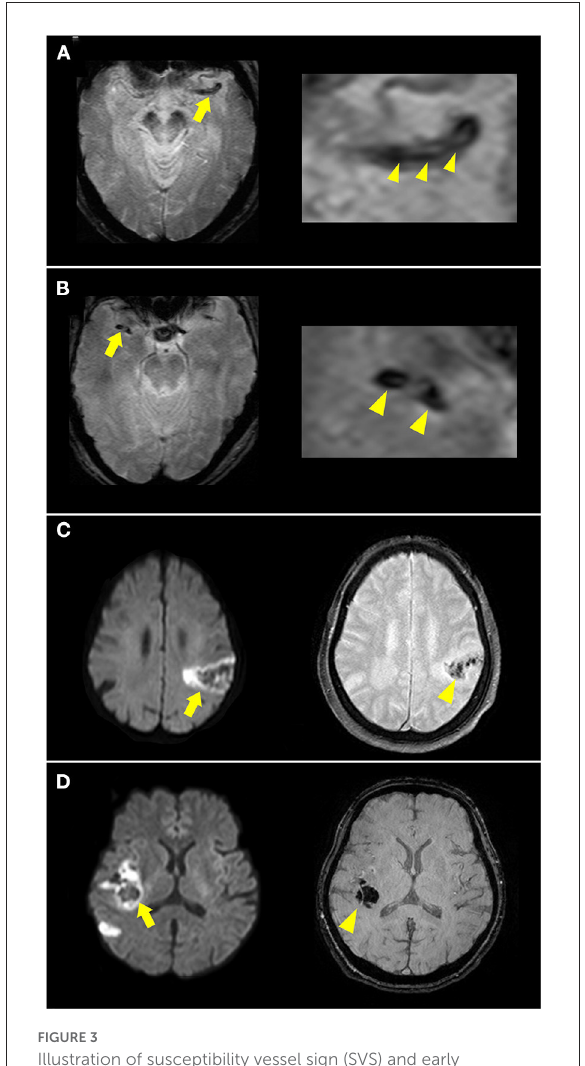
FIGURE3 Illustration of susceptibility vessel sign (SVS) and early hemorrhage. (A) A hypointense signal was noted at the left occluded middle cerebral artery (MCA) [ (A) , arrow] in T2*-weighted imaging, with a low-intensity core surrounded by a signal of higher intensity [ (A) arrowheads], suggesting a 2-layered SVS. (B) A homogenous hypointense signal was noted at the right occluded MCA [ (B) , arrow and arrowheads] in T2*-weighted imaging suggesting SVS. (C) DWI showed acute infarction in the left MCA territory with restricted diffusion and hypointense lesions inside (arrow). T2*-weighted imaging showed hypointense signal changes (arrowhead) suggesting hemorrhagic infarction. (D) DWI showed acute infarction in the right MCA territory (arrow). Susceptibility-weighted imaging showed a hypointense space-occupying lesion (arrowhead) suggesting parenchymal